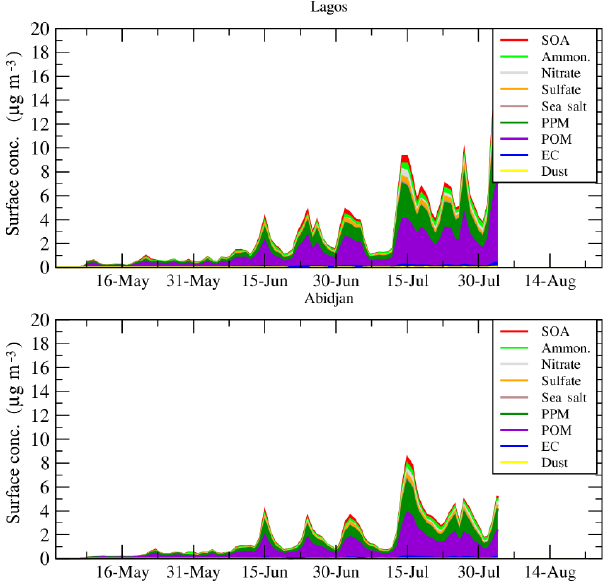
Figure 10. Time series of daily averaged surface concentrations of differences PM 10 (FIRE)–PM 10 (NoFIRE) (in µgm − 3 ). The specia- tion is presented for all aerosol species modelled with